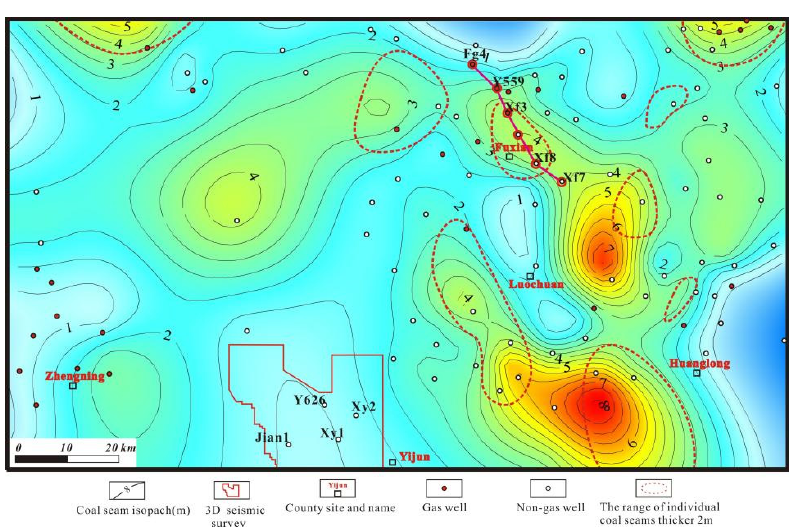
Figure 7. Coal seam isopach map of the Shannxi Formation on the southeastern margin of the Ordos Basin.